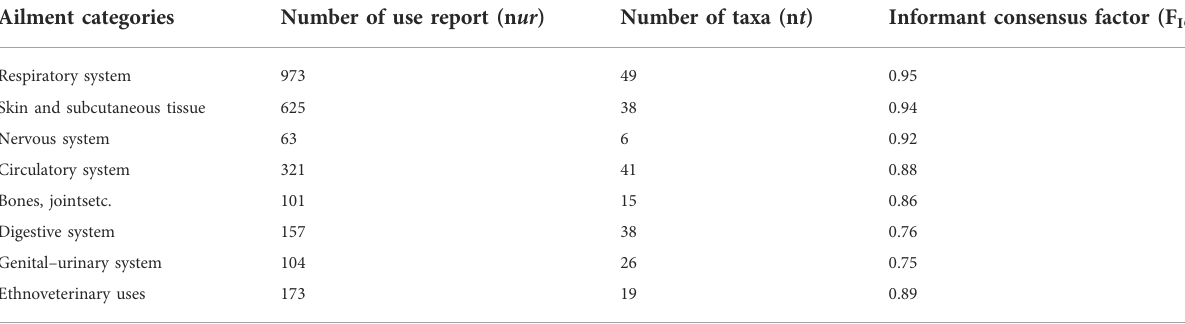
TABLE 2 F IC Values of category of ailments.